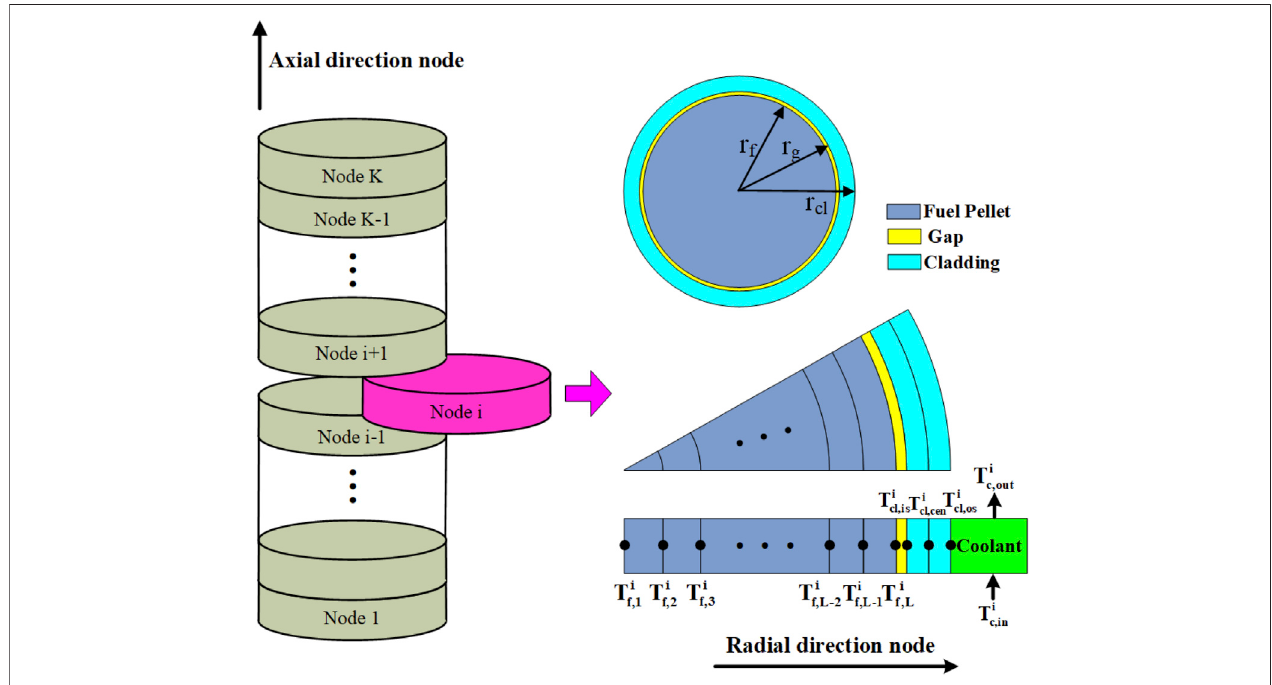
FIGURE 3 | Node division in a fuel element.